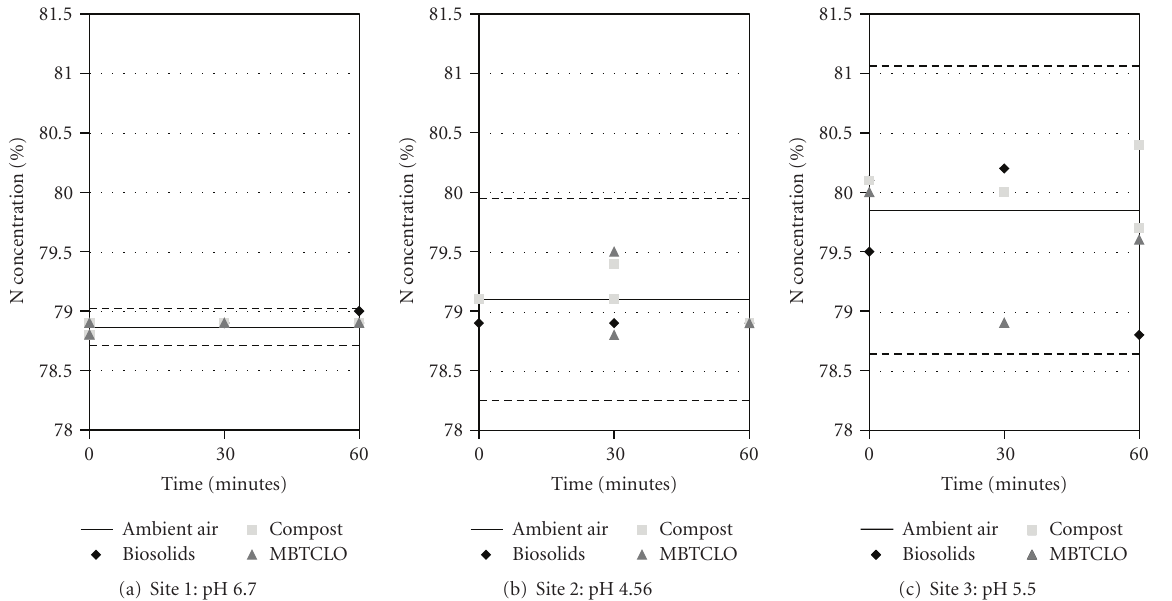
Figure 9: Measured nitrogen concentrations. The solid line indicates the mean, and the dashed line 3 standard deviations from the mean.